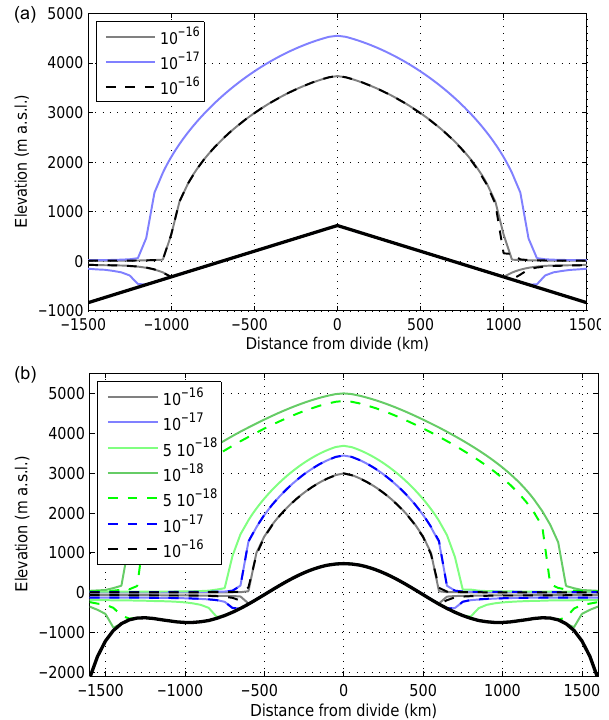
Figure C1. Steady-state ice sheet–ice shelf profiles for the MISMIP experiments corresponding to different values of the flow param- eter A (Pa − n a − 1 ) along the centreline for the downward-sloping bedrock (upper panel) and the overdeepened bedrock case (lower panel) according to the advance (solid line) and retreat (dashed line) experiments and a grounding-line flux condition according to Eq.